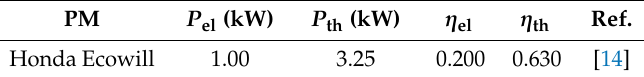
Table 2. Prime mover nominal performance.